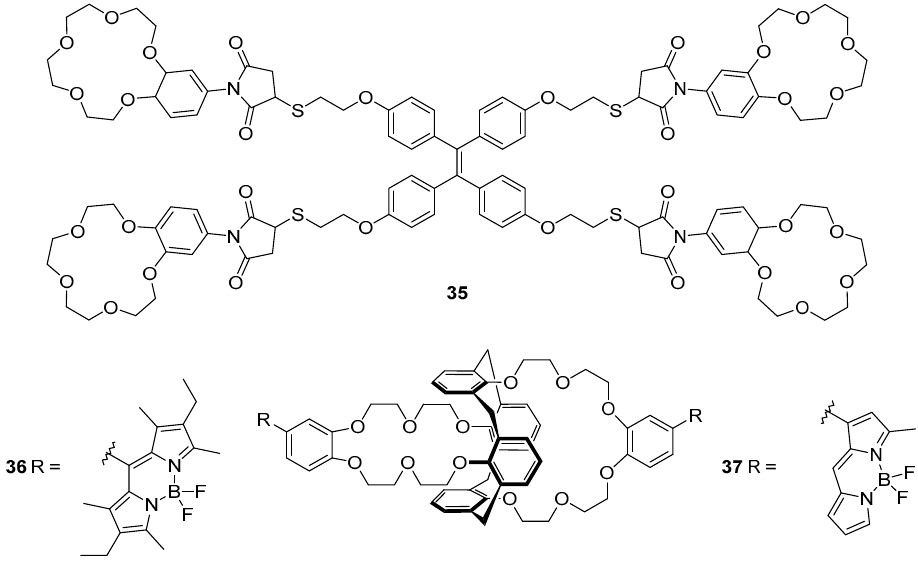
Figure 15. Crown ethers 35 – 37 have proved effective probes for monovalent cations. The tetrameric TPE derivative 35 shows a fluorescence enhancement in response to K + , forming a 1:2 35 ·K + complex in which each cation is sandwiched between two crown ether units [112]. The BODIPY-based systems 36 and 37 respond to Cs + [113].